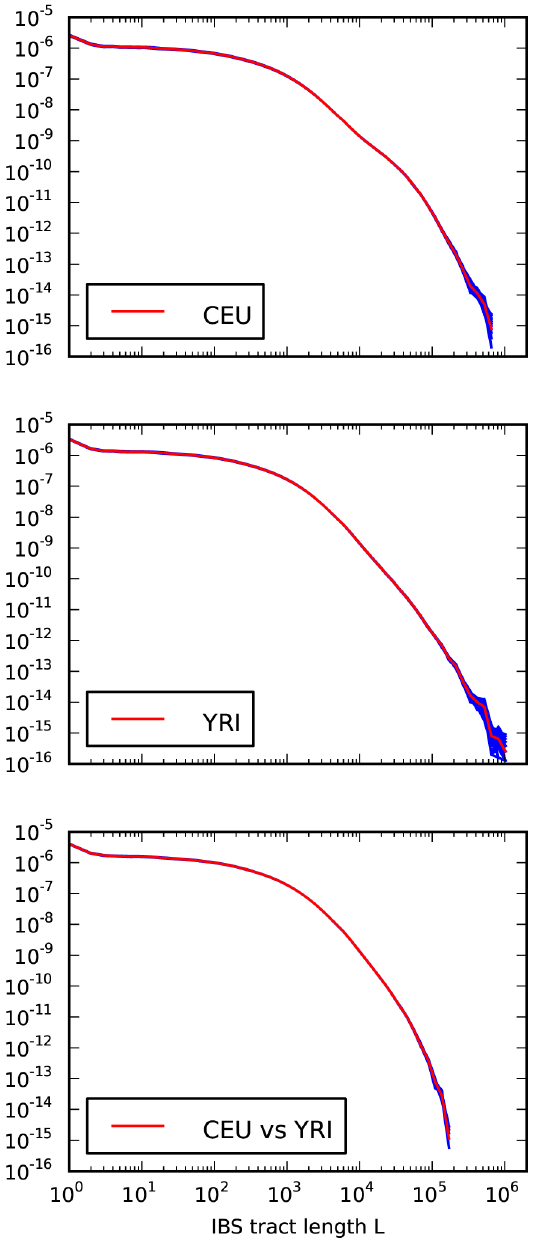
Figure 4. Frequencies of IBS tracts shared between the 1000 Genomes trio parental haplotypes. Each plot records the number of L -base IBS tracts observed per base pair of sequence alignment. The red spectrum records tract frequencies compiled from the entire alignment, while the blue spectra result from 100 repetitions of block bootstrap resampling. A slight upward concavity around 10 4 base pairs is the signature of the out of Africa bottleneck in Europeans.